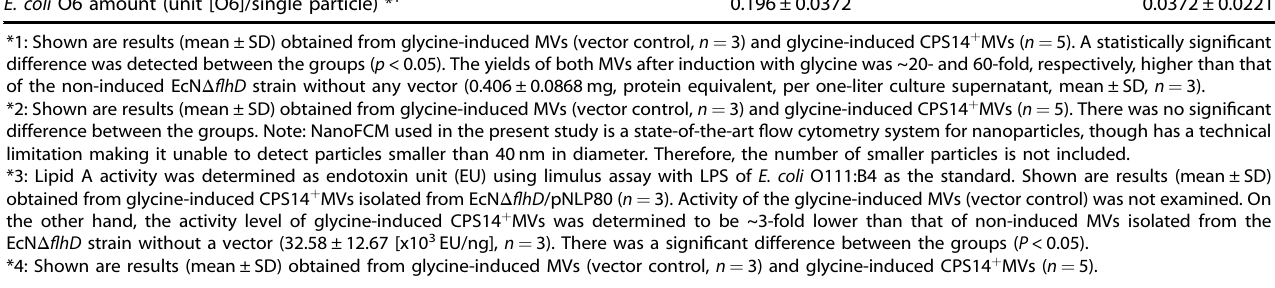
(Table 1 and Supplementary Fig. 4). Using limulus assay fi ndings, the amount of LPS in glycine-induced CPS14 + MVs was calculated to be 10.2 ± 6.82 (endotoxin units [EU] × 0 3 /ng) (Table 1), signi fi cantly less than the amount in non-induced MVs of